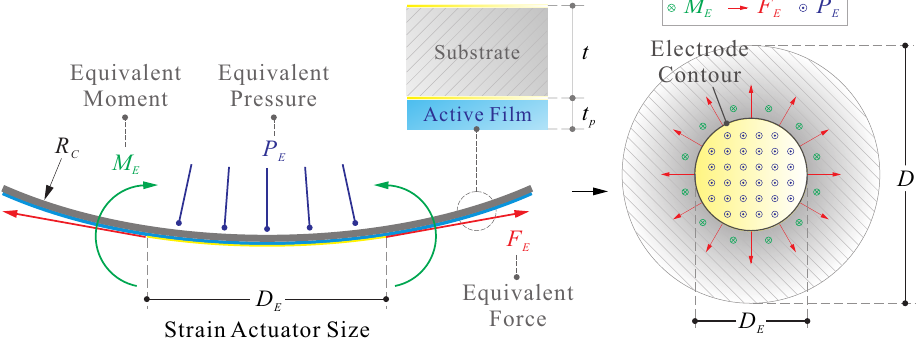
Figure 5. An illustrative diagram of equivalent loads for a unimorph strain actuator acting on a spherical